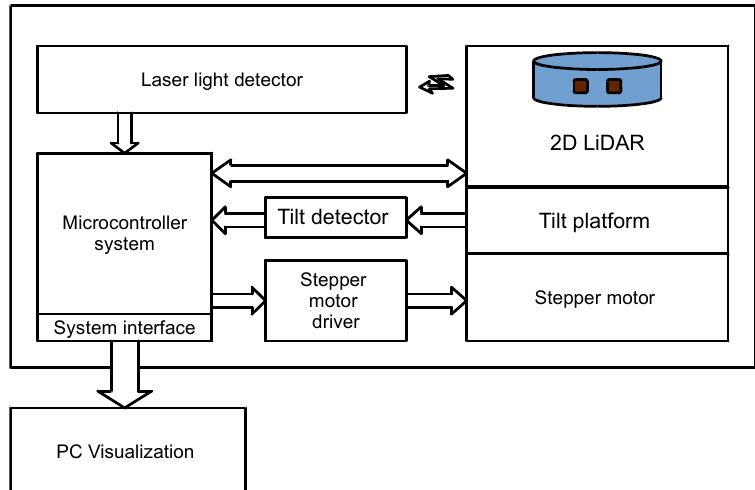
Figure 3. Block diagram of the scanning mechanism control system.